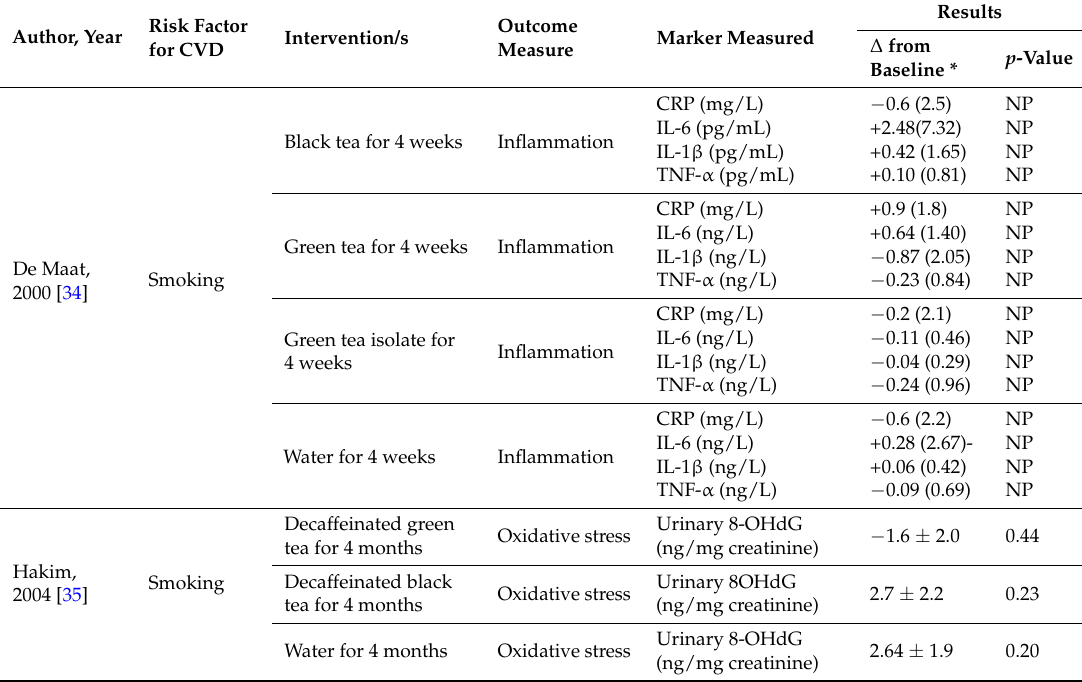
Table 11. Effect of tea polyphenols on oxidative stress and